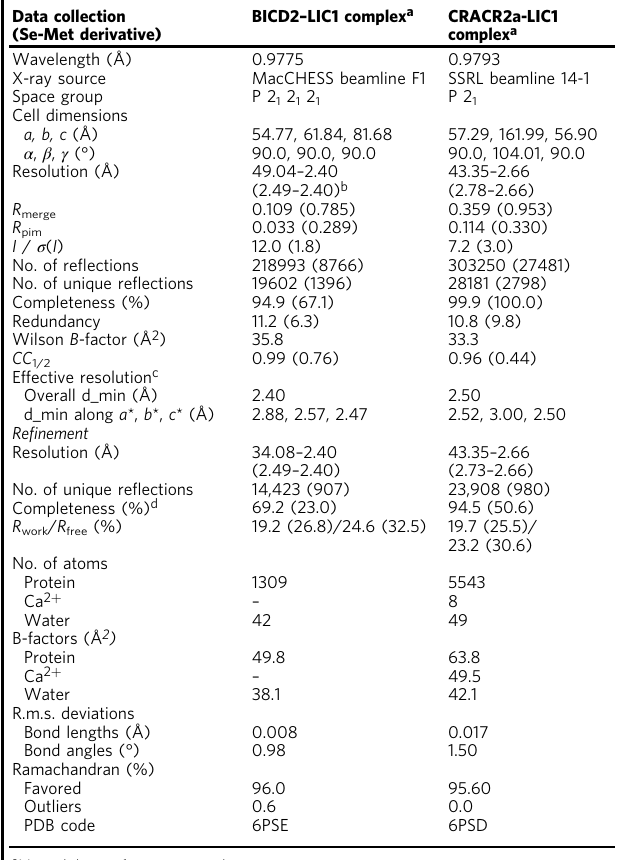
Table 1 Data collection and re fi nement